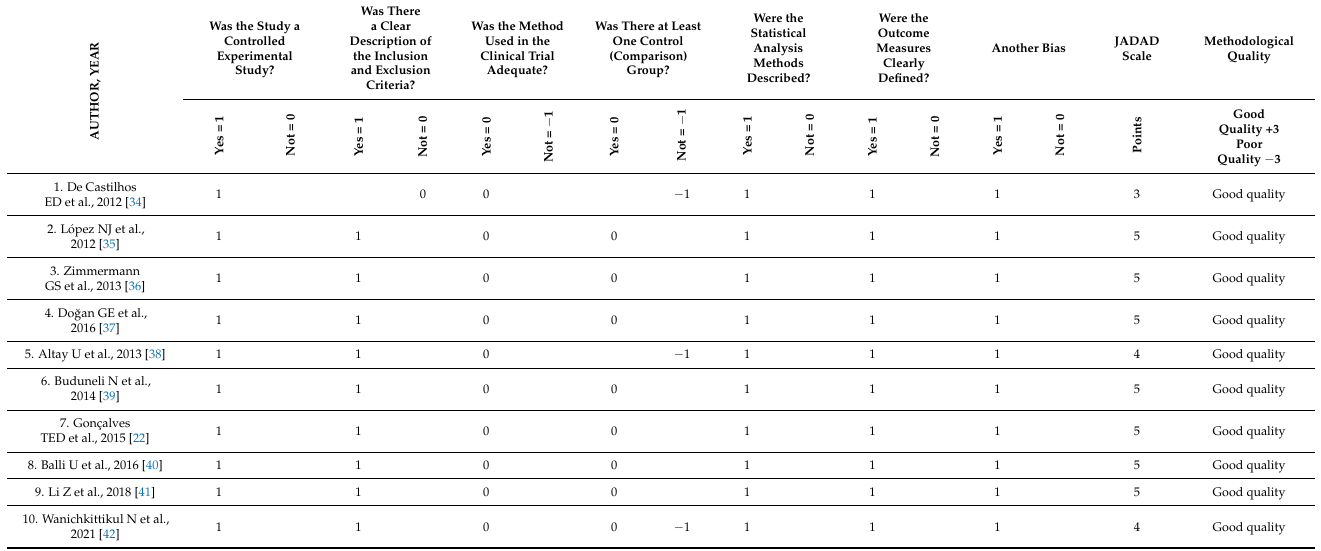
Table 1. JADAD scale for assessing the overall quality of